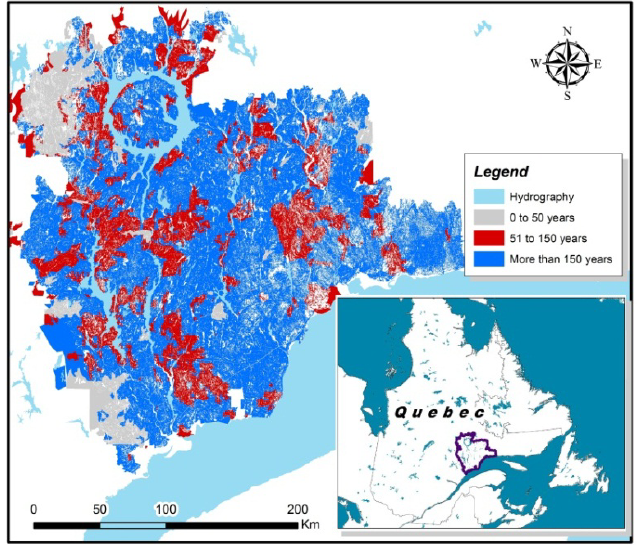
Figure 6. Historical fire map from the North Shore region (data obtained from